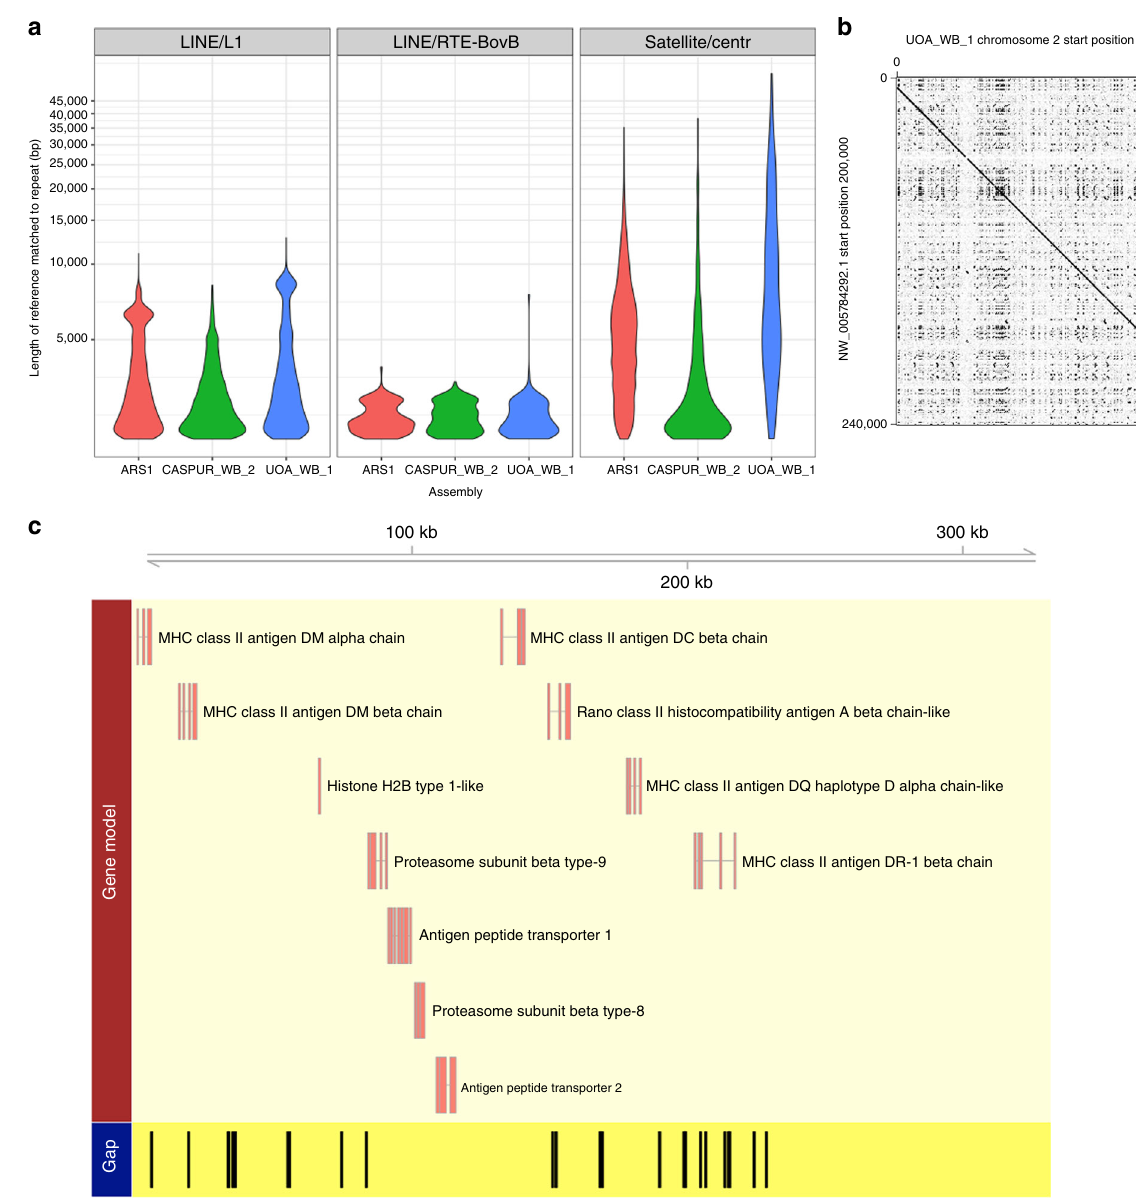
Fig. 5 Resolution of hard to assemble repetitive and polymorphic regions. a Violin plot of repeat lengths >2 kb for LINE/L1, LINE/RTE-BovB and satellite/ centromeric repeats for ARS1, UMD_CASPUR_WB_2.0 and UOA_WB_1 assemblies. b Dot plot of a ~218 kb region of MHC class II in UOA_WB_1 (horizontal) against UMD_CASPUR_WB_2.0 (vertical) showing a substantial level of repetition throughout the region. c Resolved MHC class II genes present on the single contig in UOA_WB_1 also shown in b . Protein-coding genes in UOA_WB_1 are shown for the same single contig, with assembly gaps for the same region in